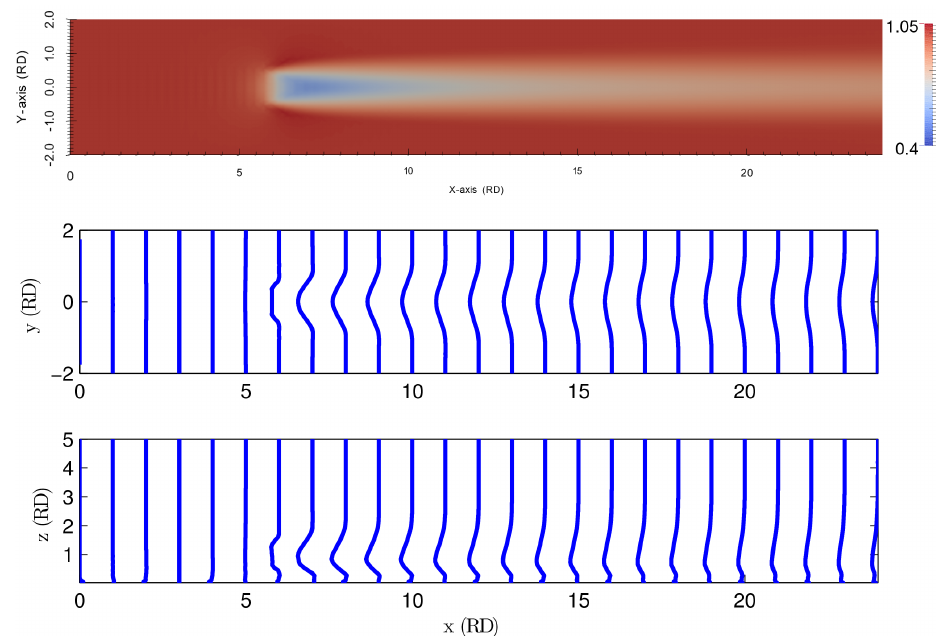
Figure 4. Flow past a single turbine obtained using the 3-D RANS flow solver. The top panel shows the velocity at hub height and the bottom two panels show profiles of the velocity deficit in horizontal and vertical planes passing through the center of the wind turbine rotor. Velocity deficits are relative to the respective profiles 3RD upstream of the turbine and the velocities are normalized by the incoming hub-height velocity. Axes are in units of rotor diameter RD = 80m.